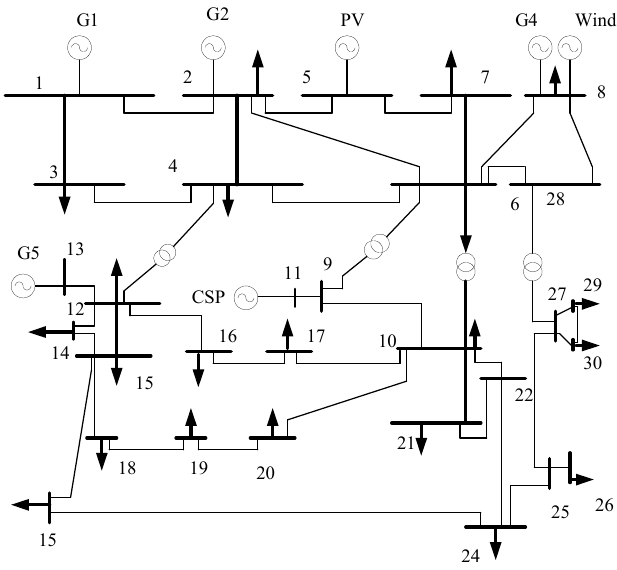
Figure 3. Wiring diagram of IEEE 30 bus system. Table 1. Parameters of the thermal power units.